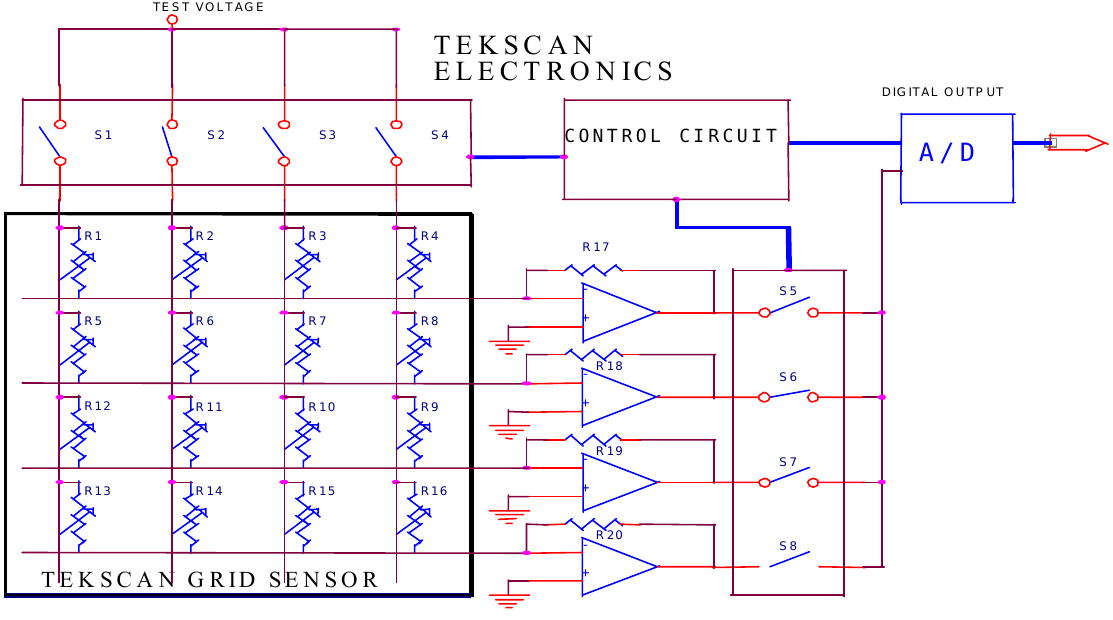
Figure 13. Structure of the I-Scan system [53].